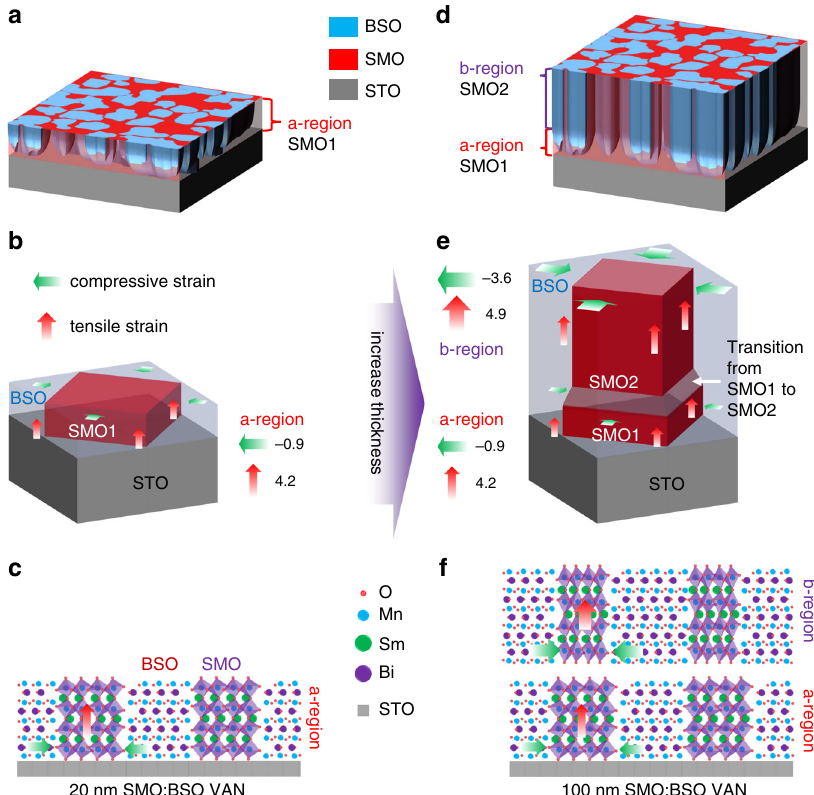
Fig. 5 Model of structure and strain evolution in SMO VAN Films. a – c In the 20 nm VAN fi lm, SMO is clamped to the STO substrate. This takes place by ‘ a ’ expanding while ‘ b ’ contracts. ‘ c ’ expands marginally. This produces the o -SMO1 phase i.e. the ‘ a-region ’ . d – f As the fi lm thicknes increases to 100 nm, the in fl uence of the STO is much weaker and now vertical strain from the BSO pillars dominates the strain state in the fi lm. Here, ‘ c ’ expands owing to domain matching epitaxy growth vertically with BSO. At the same time, there is biaxial lateral (in-plane) pressure from the BSO on SMO leading to a large in-plane contraction along both ‘ a ’ and ‘ b ’ . Hence, the compressive in-plane ( d 110 ) strain (green arrow) and tensile out-of-plane strain (red arrow) increases from 4.2% and − 0.9% in o-SMO1 to 4.9% and − 3.6% in o-SMO2 respectively.